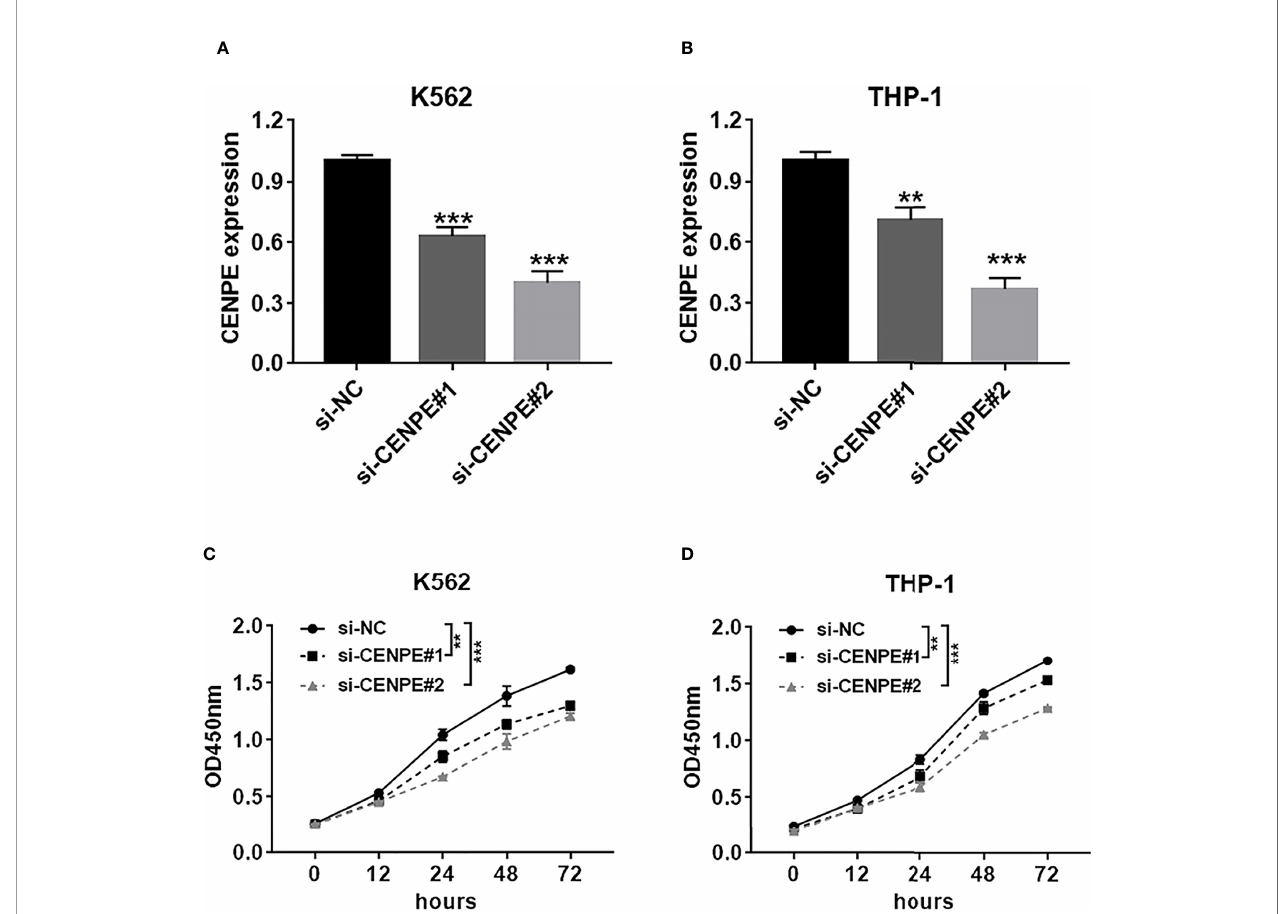
FIGURE 2 | CENPE interference inhibited K562 and THP-1 cell proliferation. (A, B) K562 and THP-1 cells were transfected with si-NC, si-CENPE#1, or si- CENPE#2. Knockdown ef fi ciency of CENPE in K562 and THP-1 cells was measured by RT-qPCR. (C, D) Cell proliferation was evaluated by CCK-8 assay, and si- CENPE signi fi cantly inhibited K562 and THP-1 cell activities compared with the si-NC group. ** p < 0.01. *** p <